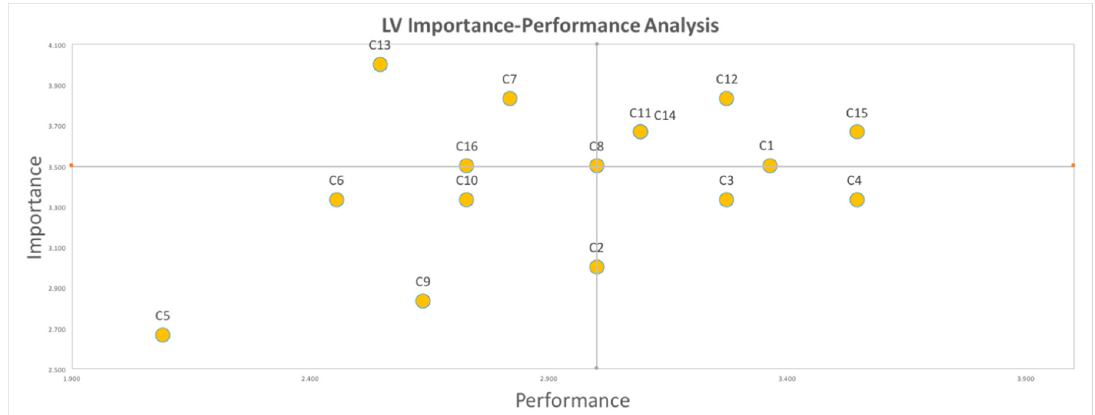
Figure 2. IPA chart based on data gathered in Latvia, 2019 (created by authors). where C1—Spotting